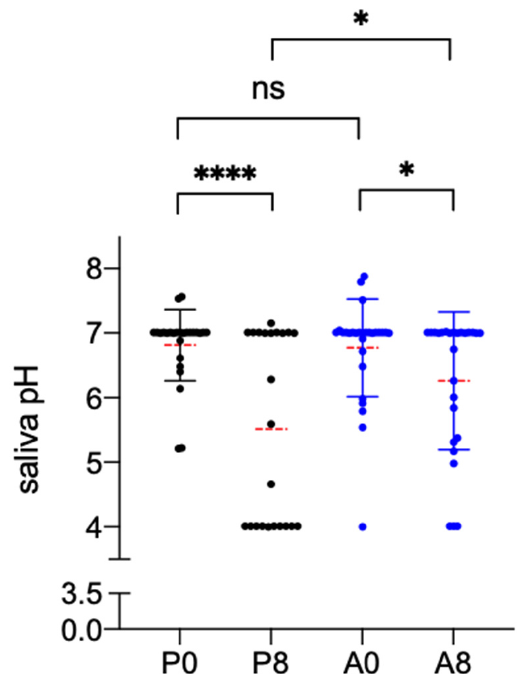
Figure 2. Effect of Placebo and Aqualief TM treatment on saliva pH. Saliva pH, determined by potentiometric analysis, was recorded before (P0,A0) and after one week (P8,A8) of treatment. P is for placebo, A for Aqualief TM , * p < 0.1, **** p < 0.0001, ns, no significant differences. Statistical analysis between the two time points of the same group was performed by paired t -test, between the two groups by unpaired t -test.